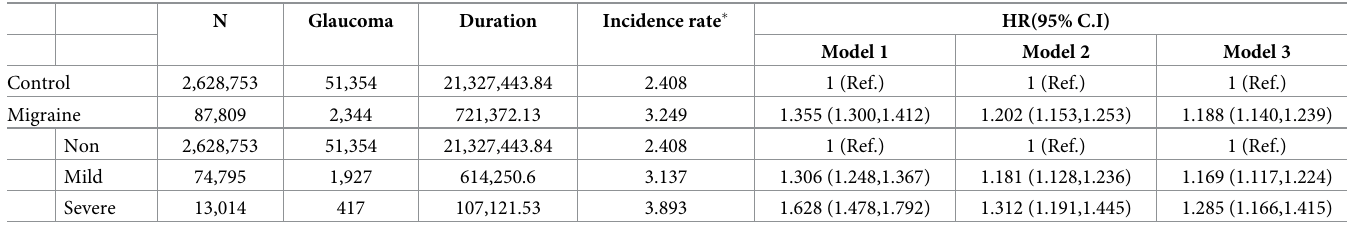
Table 2. The risk of POAG according to the presence and severity of